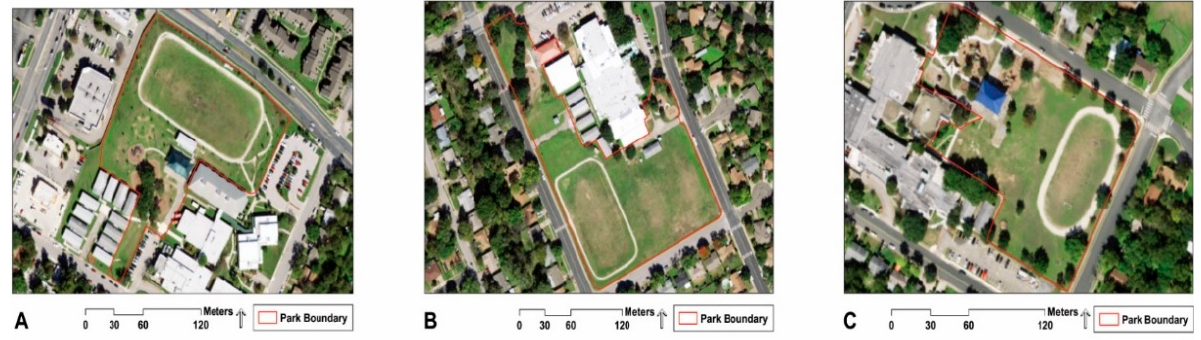
Figure 1. ( A ) Intervention park, ( B ) low-green park, and ( C ) high-green park.